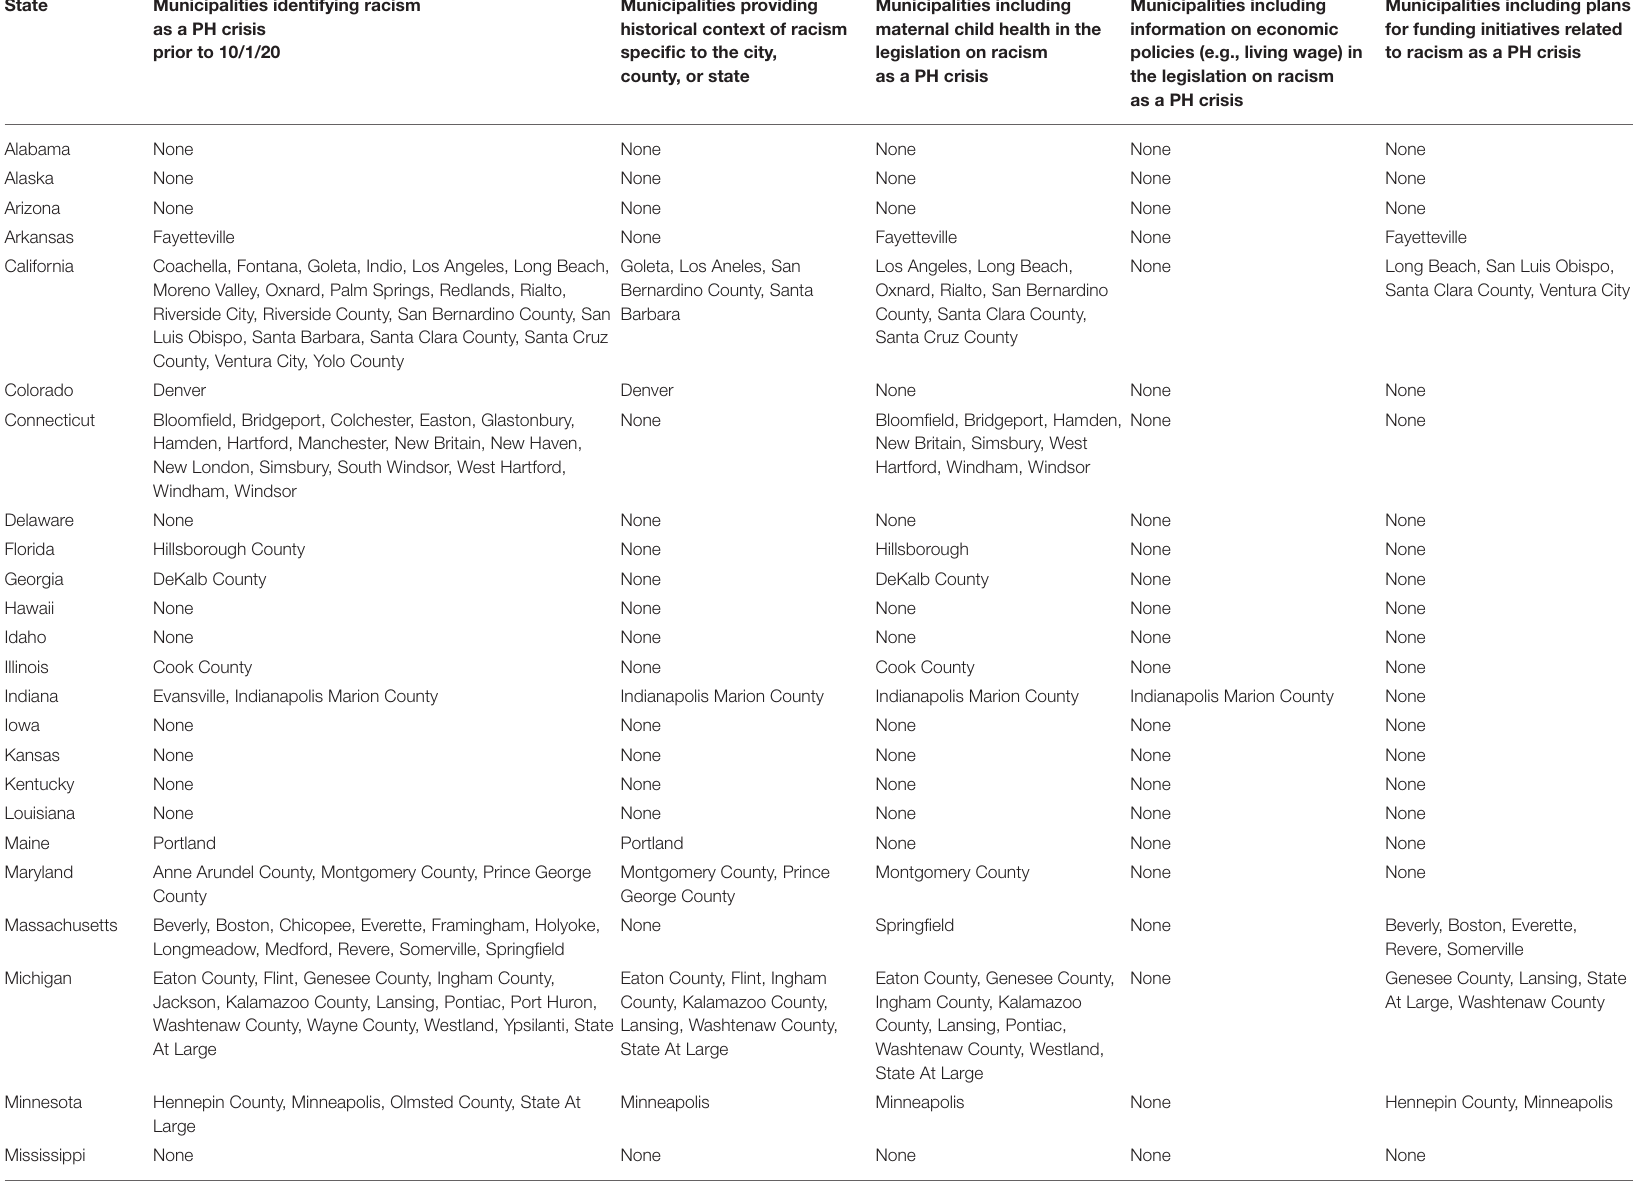
TABLE 1 | Racism as a Public Health Crisis legislation summary by state through September 30,